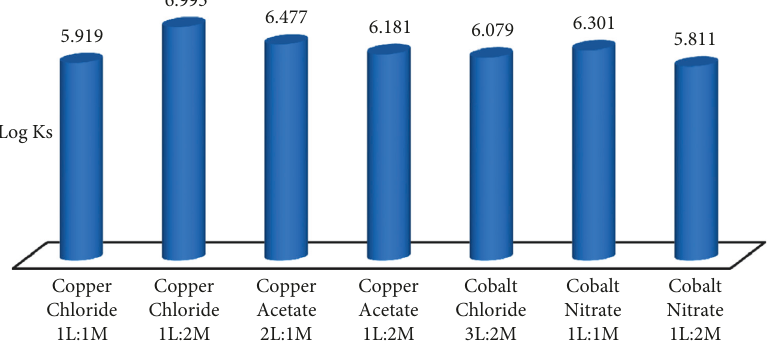
Figure 4: Stability constants of metal precursors with DMBH.